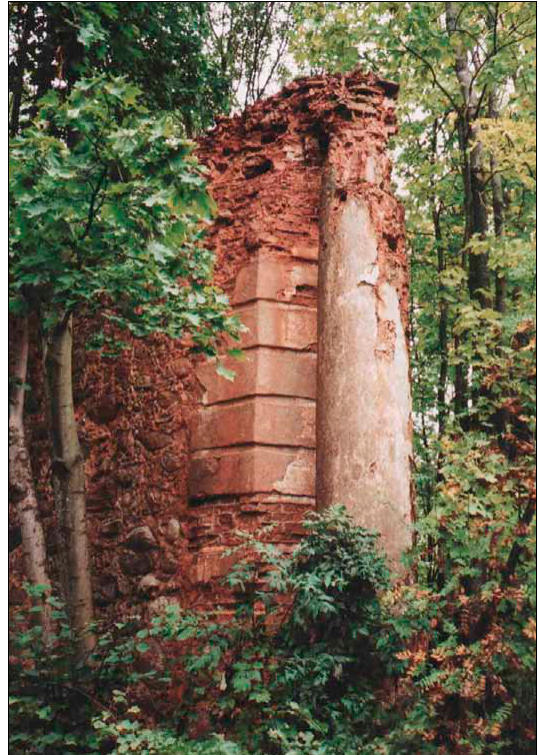
fig. 7. Svorotva Vialikaya. Holy Trinity uniate church (masonry), 1823. The column in the Southern corner. Photo: j.-K. lenartowicz